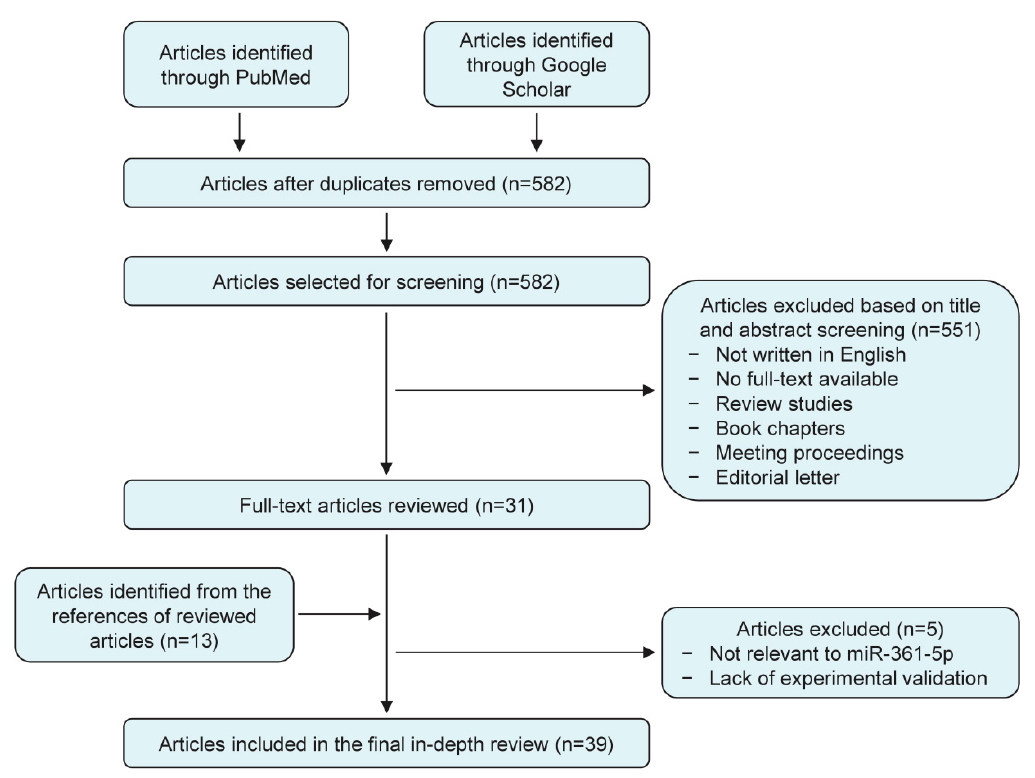
Figure 1. Summary of literature search, screening and selection.